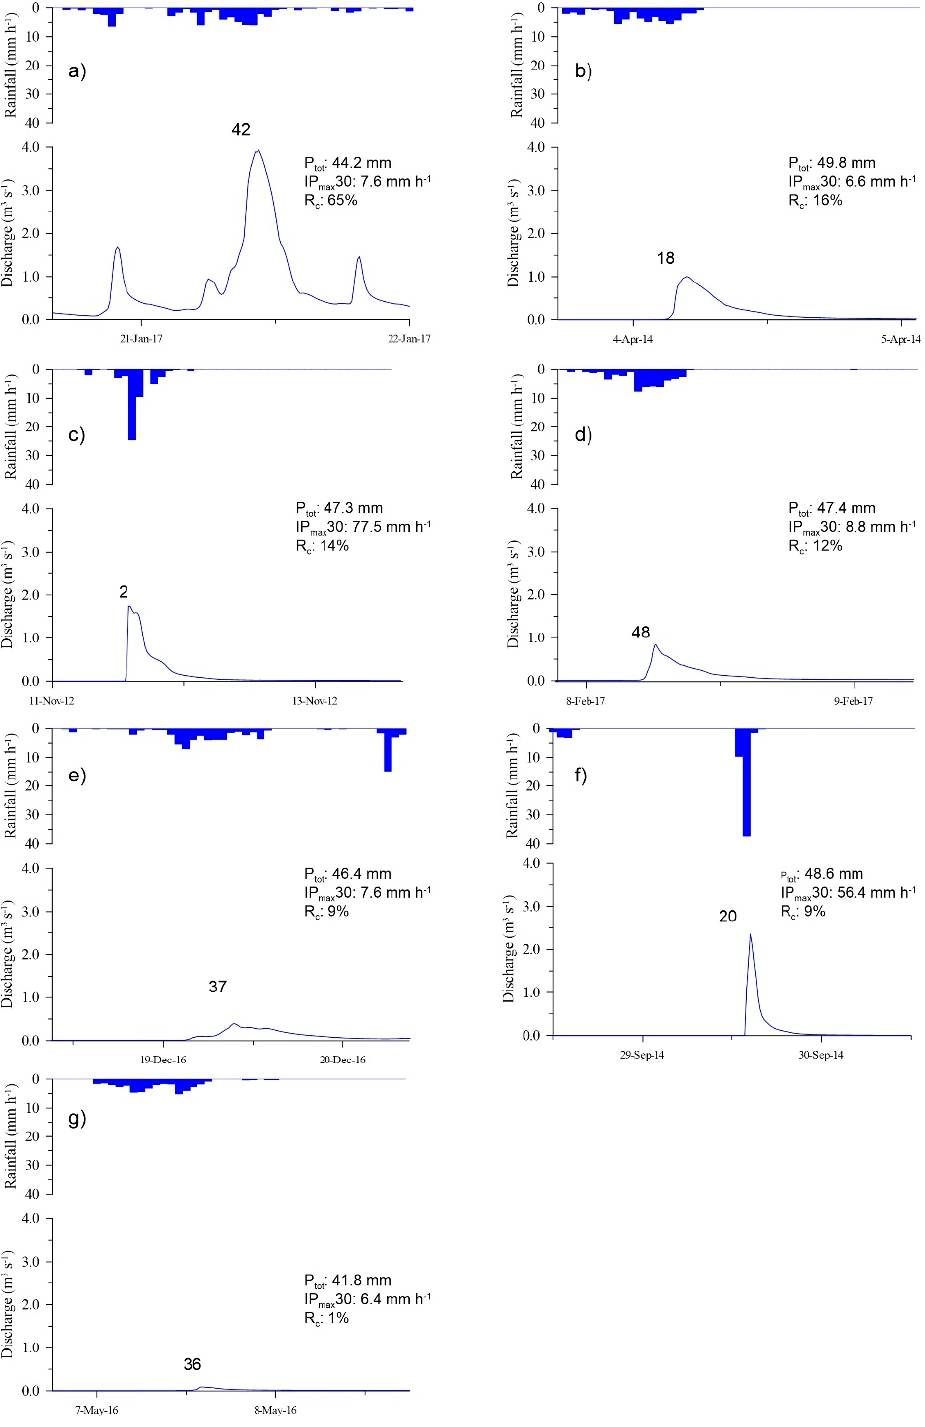
Figure 6. Selected events for non-linearity analysis at Es Fangar Creek. Events with a total precipitation between ca. 40 and 50 mm. The numbers located at the peak of each hydrograph indicate the ID of the events recorded in Es Fangar Creek during the study period 2012–2017, further exposed in Table A3.